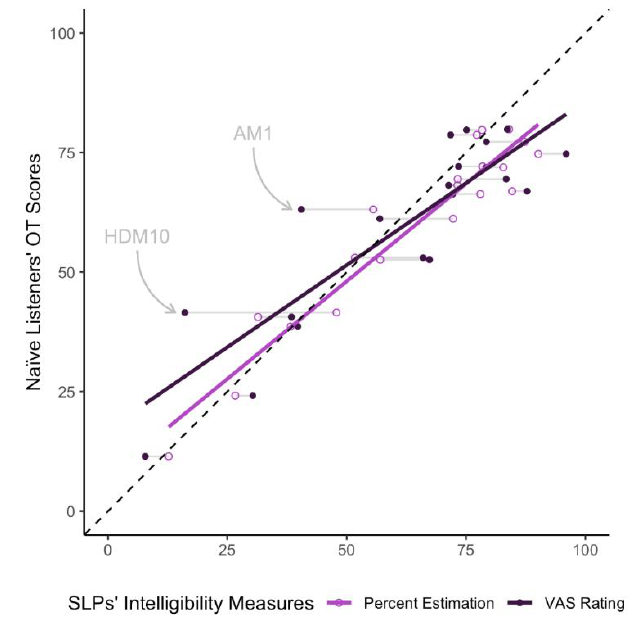
Figure 4. SLPs’ Percent Estimates and VAS Ratings of Intelligibility as Predictors of Naïve Listeners’ Orthographic Transcriptions. OT = orthographic transcription; SLP = Speech-language pathologists, VAS = visual analog scale. The light gray line connects the data points for each of the 20 speakers. Two speakers, AM1 and HDM10, are highlighted within the figure and discussed in Section 4.2 of the